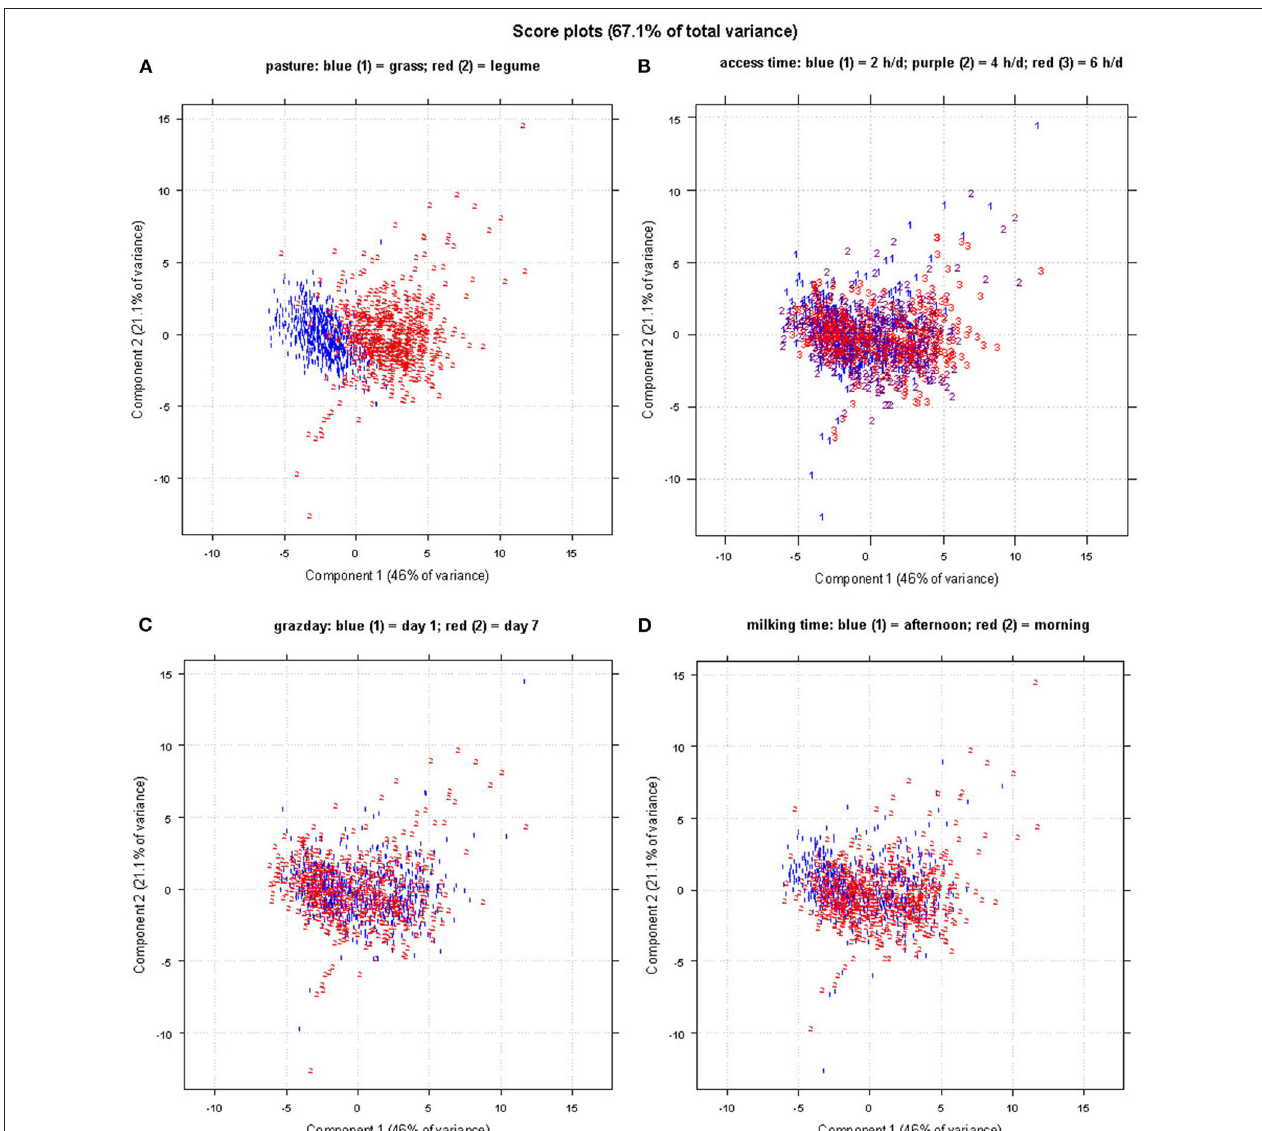
FIGURE 3 | Score plot of the principal component analysis (PCA) obtained using the fatty acid (FA) profile data set; samples are labeled and colored as for the classifications of (A) pasture forage, (B) access time, (C) grazing day, and (D) milking